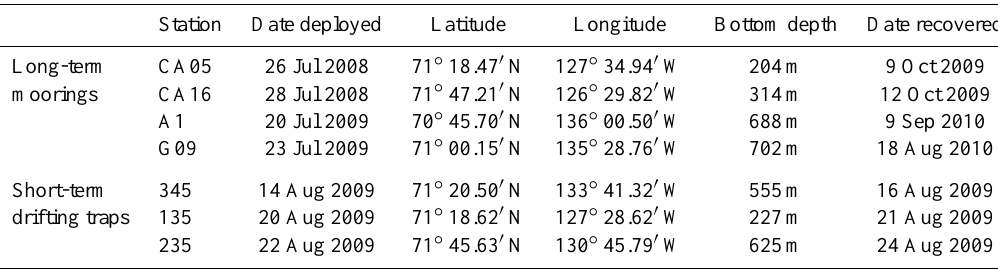
Table 1. Locations and periods of deployment of the long-term moorings and short-term drifting traps used in the present study. The location of each station is mapped on Fig.